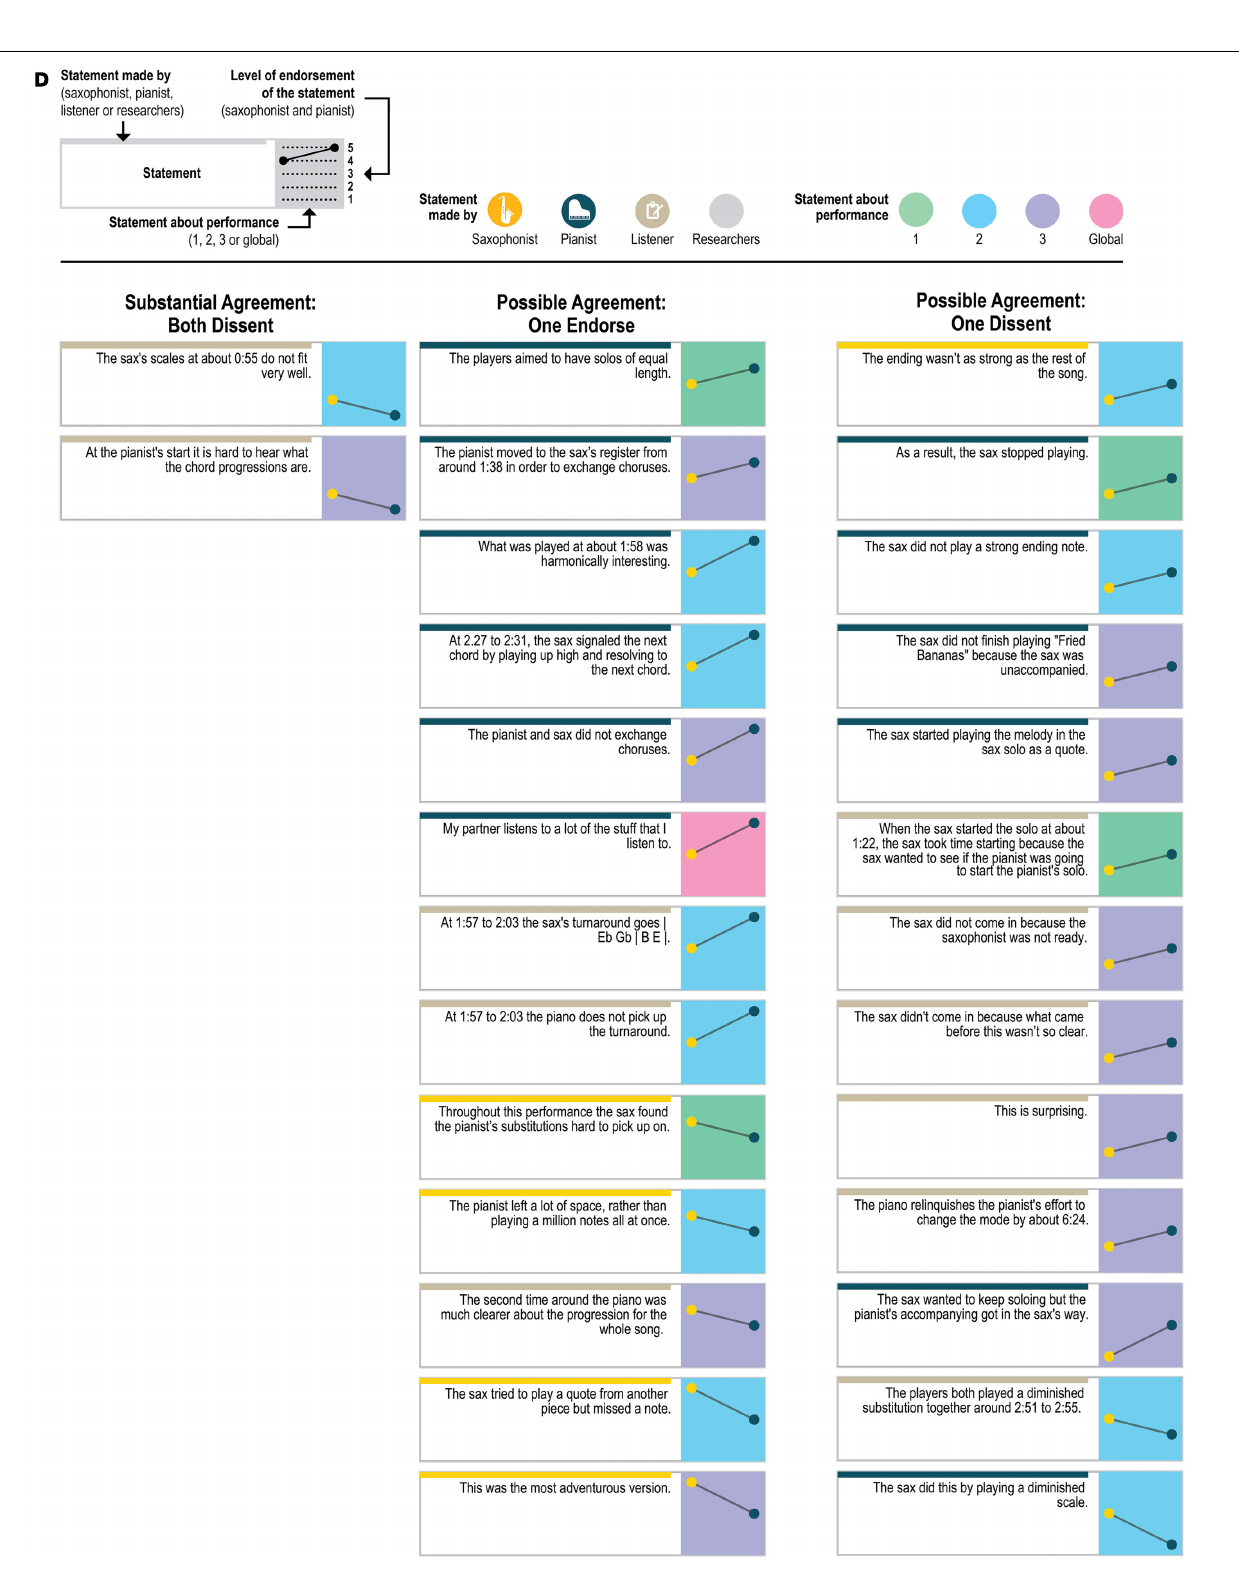
Frontiers in Psychology | Cognitive